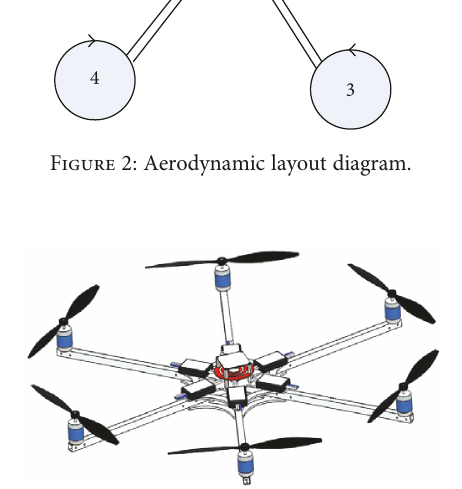
Figure 3: Six-rotor UAV platform assembly